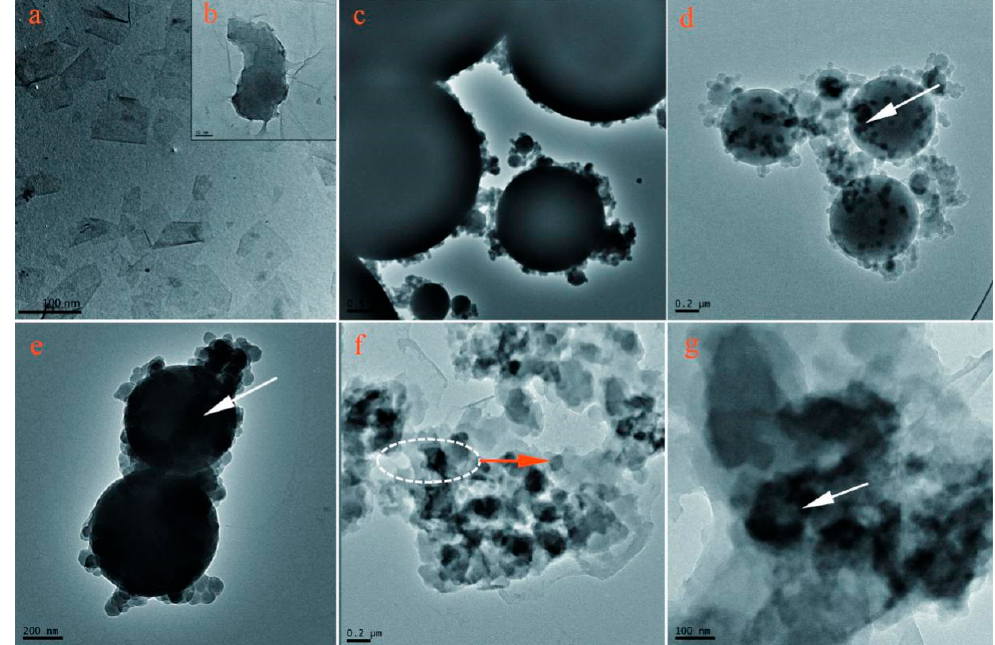
Figure 10. TEM morphologies of microcapsule samples, ( a , b ) pure graphene, ( c ) M-0, ( d ) M-4, ( e ) M-5, and ( f , g ) shell materials of M-5.